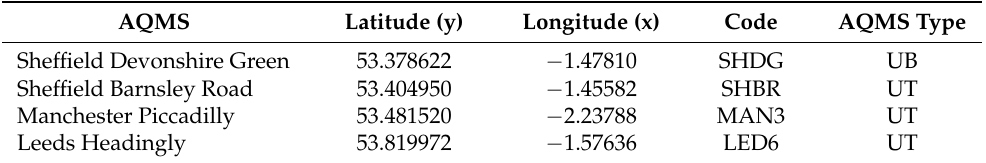
Table 2. Names, environment types, and geographical coordinates of the air quality monitoring sites